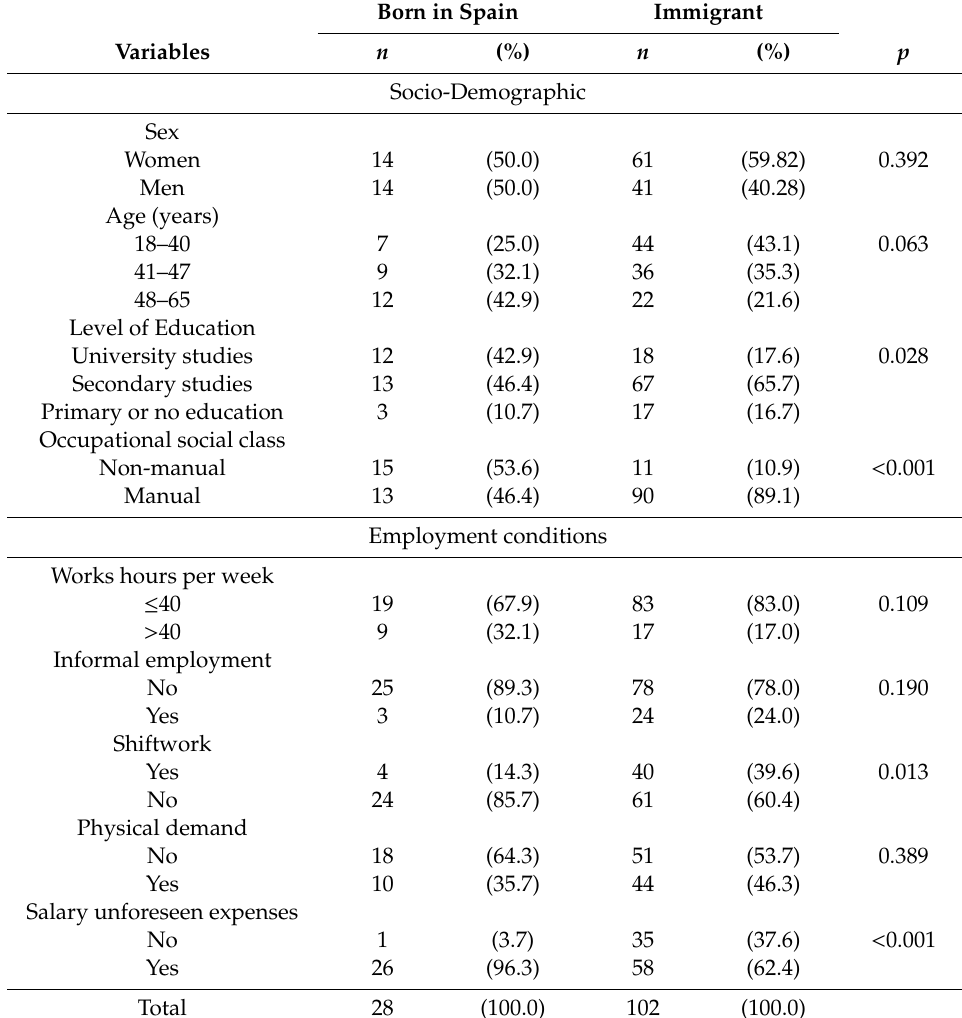
Table 1. Distribution of workers included in the study by socio-demographic characteristics, and employment conditions by migration status. Born in Spain